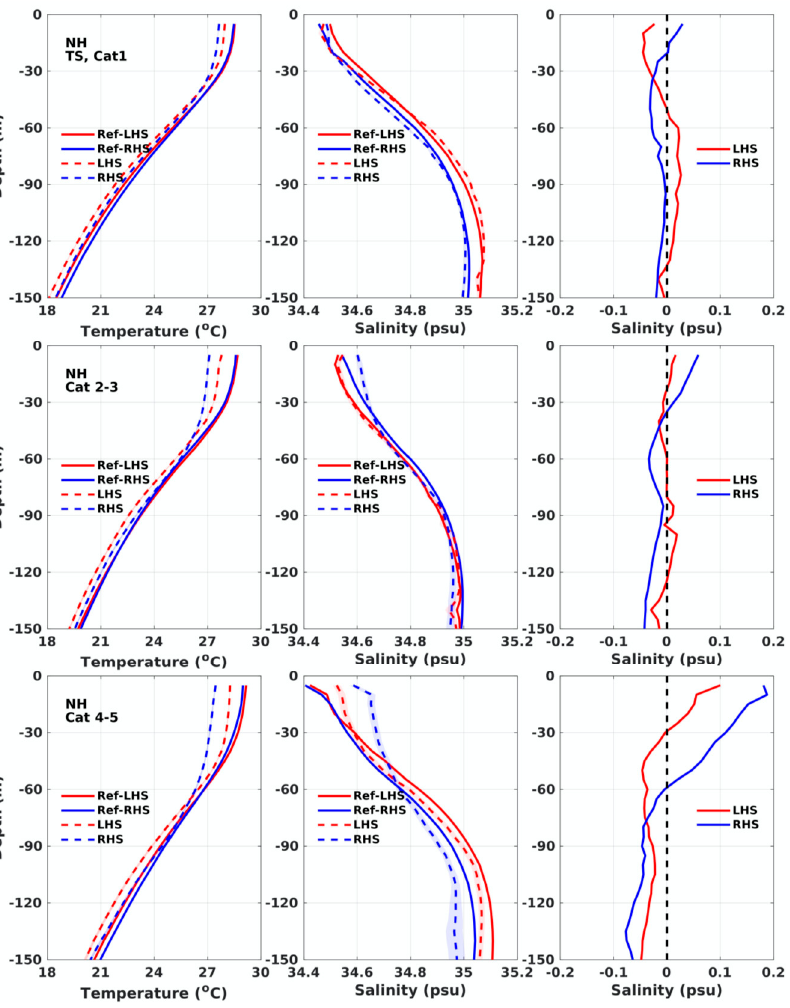
Figure 10. The same with the upper panels of Figure 8, except that the Argo profiles during TS and Category 1 TCs (upper panels), Category 2–3 (middle panels) and Category 4–5 (lower panels) in the Northern Hemisphere are composited.